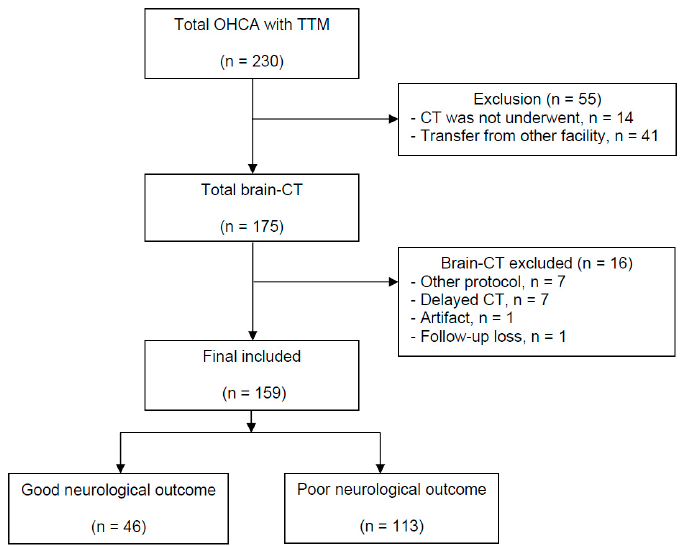
Figure 1. Flow diagram of the included patients. OHCA, out-of-hospital cardiac arrest; TTM, targeted temperature management; CT, computed tomography. Table 1. Baseline characteristics of the included patients.